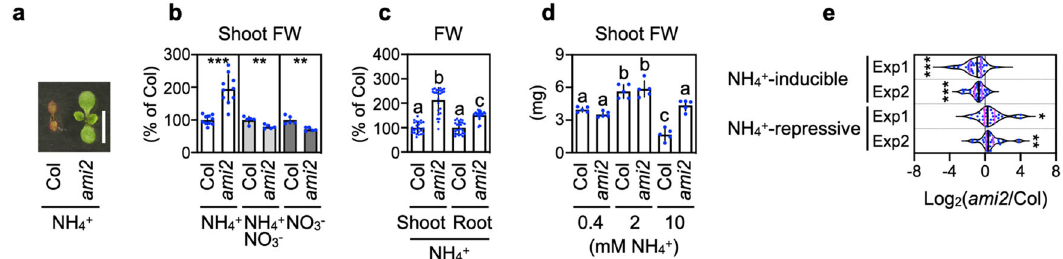
Fig. 1 Enhanced shoot growth of ami2 in the presence of 10 mM ammonium. a A representative photograph of shoots from the 11-d-old wild-type (Col) and ami2 grown on media containing 10 mM ammonium. The scale bar represents 5 mm. b Fresh weights (FW) of shoots from 11-d-old Col and ami2 grown on media containing 10 mM ammonium (mean ± SD; n = 10), 5 mM ammonium nitrate (mean ± SD; n = 5), or 10 mM nitrate (mean ± SD; n = 5). c FW of shoots and roots from 11-d-old Col and ami2 grown on media containing 10 mM ammonium (mean± SD; n = 26). d FW of 11-d-old Col and ami2 shoots grown on media containing 0.4, 2, or 10 mM ammonium (mean ± SD, n = 5). e Violin plots of the differences in the expression of the ammonium stress- responsive genes between the 10-d-old Col and ami2 shoots 3 d after transfer to media containing 10 mM ammonium. The gene list was obtained from Li et al. 9 (for further details, see Supplementary Data 1). Two independent experiments (Exp1 and Exp2) were performed. Nine shoots from three plates constituted a single biological replicate. An individual violin plot shows the median (black line) and the 25th to 75th percentiles (magenta line). b , d Six shoots from one plate constituted a single biological replicate. b , e * P < 0.05; ** P < 0.01; *** P < 0.001 (Welch ’ s t -test). c , d Different letters denote signi fi cant differences at P < 0.05 (Tukey – Kramer ’ s multiple comparison